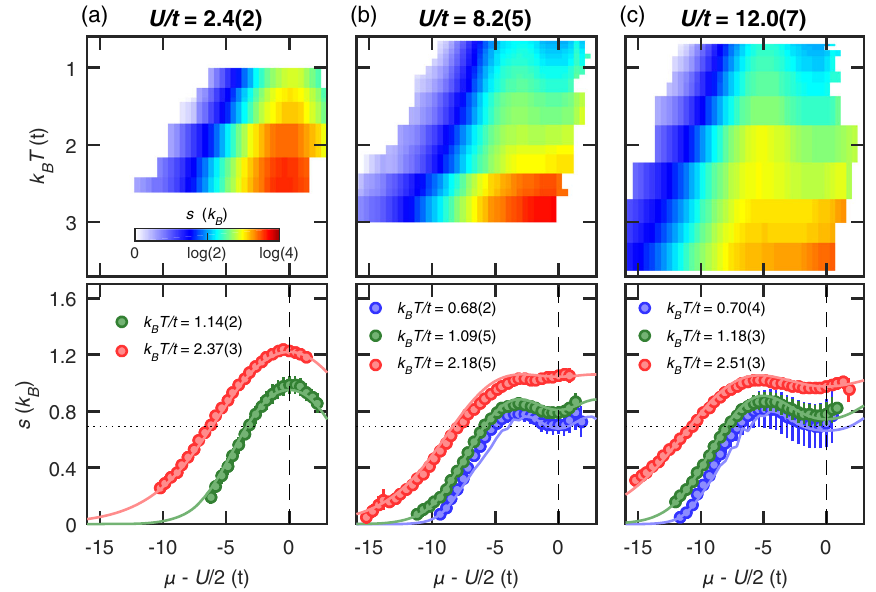
FIG. 2. Entropy per site versus chemical potential and temperature for different interaction strengths. The top row shows in color code the complete entropy data set, and the bottom row shows entropy data at selected temperatures together with the corresponding NLCE data (solid lines). The dotted horizontal line marks the value of log(2). For weak interactions (a) no Mott insulator forms and the entropy per site peaks at half filling (indicated by vertical dashed lines) at all temperatures explored. For intermediate (b) and strong (c) interactions at low temperature, one observes a local minimum of the entropy per site owing to the charge excitation gap of the Mott insulator. Horizontal errors are smaller than the marker size. The vertical error bars display the fit error of the derivative of the polynomial fit to the pressure data versus temperature. Systematic uncertainties of the entropy arising from the chosen polynomial fitting routine reach for the lowest temperatures presented values up to 0 . 1 k B